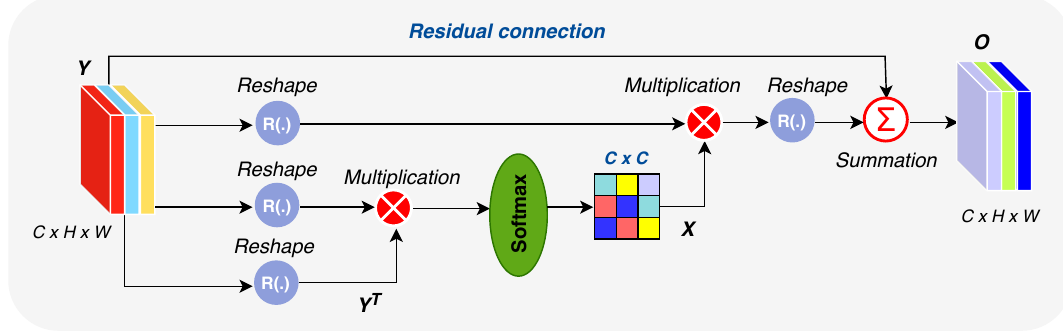
Figure 9. Diagram of our feature attention module (FAM).